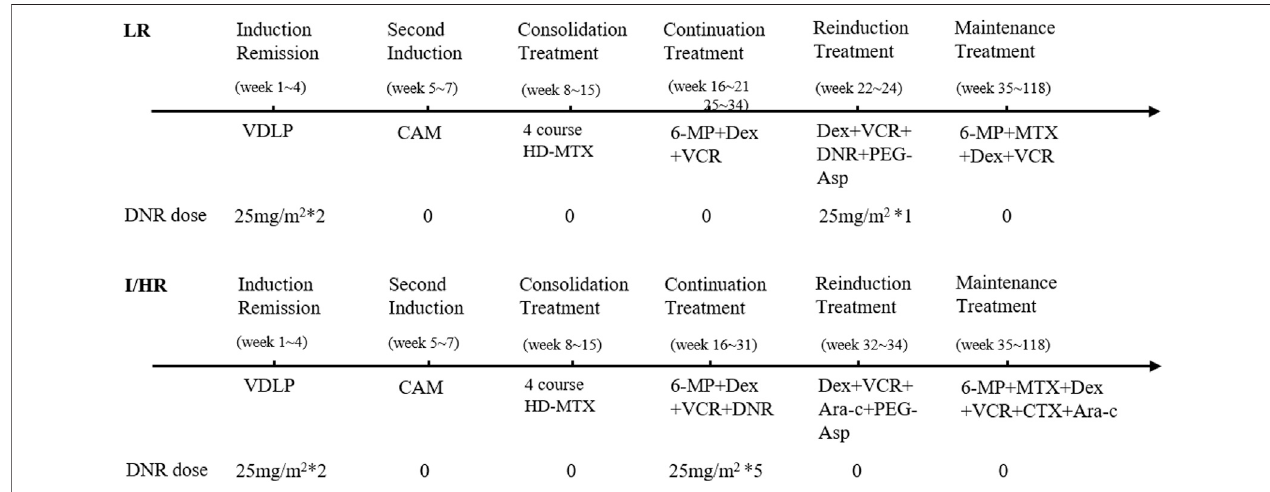
FIGURE 1 | The detailed information of DNR administration in CCCG-ALL-2015 protocol. DNR. daunorubicin; LR, low risk; I/HR, intermediate/high risk; VDLP, vincristine (VCR), daunorubicin (DNR), pegaspargase (PEG-Asp) and prednisone (P); CAM, cyclophosphamide (CTX), cytarabine (Ara-C) and mercaptopurine (6-MP); HD-MTX, high dose of methotrexate; Dex, dexamethasone.